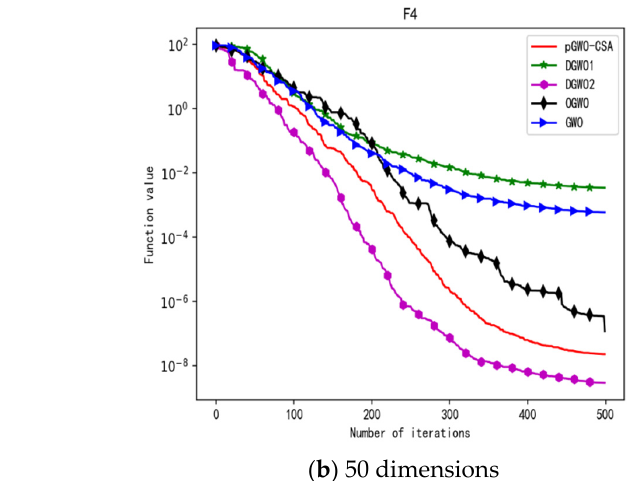
Figure 23. Convergence curve of test function F4.